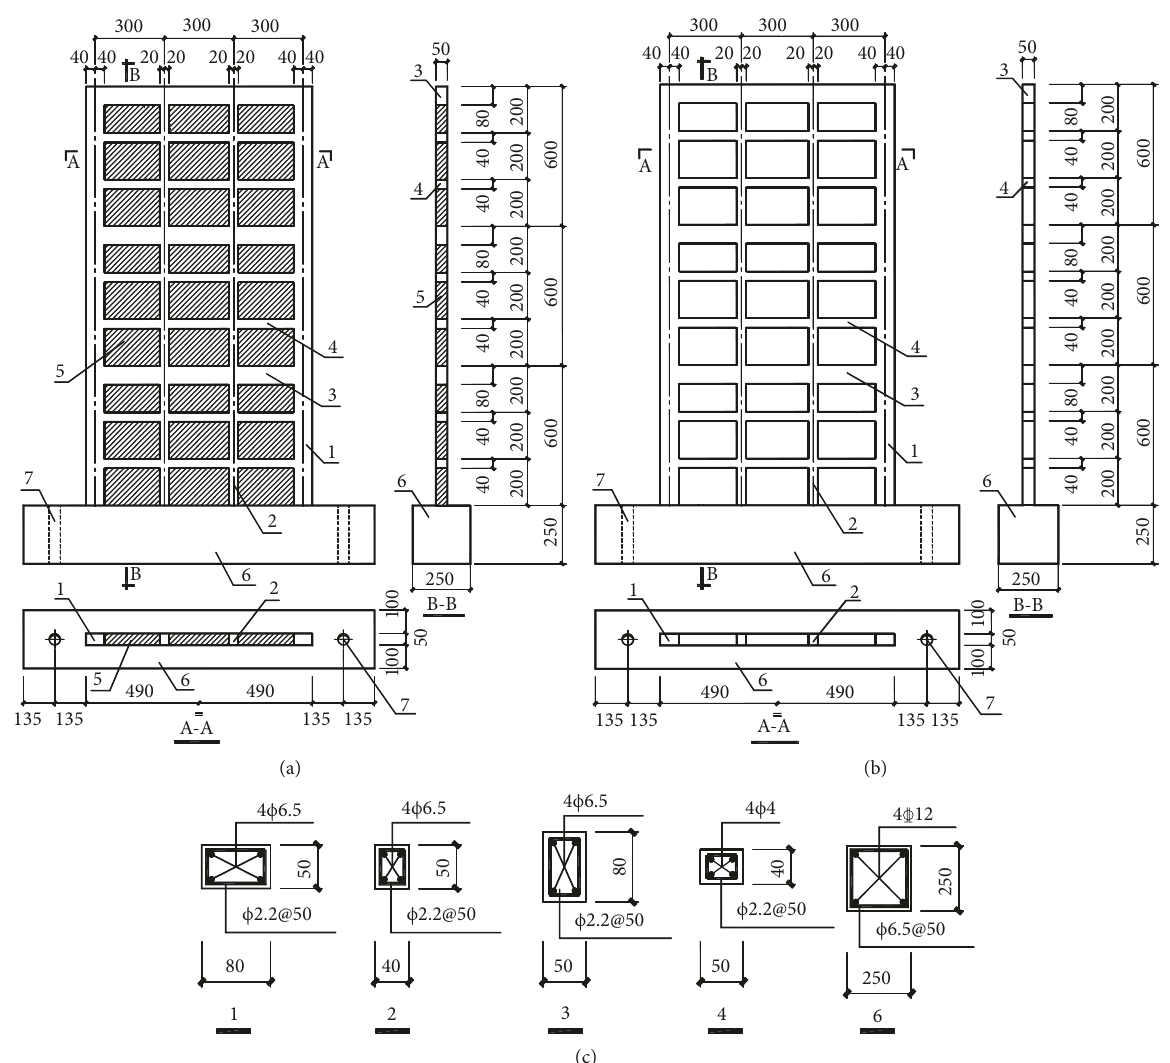
Figure 8: Geometry size and reinforcement of the specimen. (a) Specimen KJ. (b) Specimen ZHQ. (c) Reinforcement of concrete members. (1) Side pillar; (2) center pillar; (3) floor beam; (4) interstorey beams; (5) cast-in-situ phosphogypsum; (6) foundation beam; (7) anchor bolt hole.